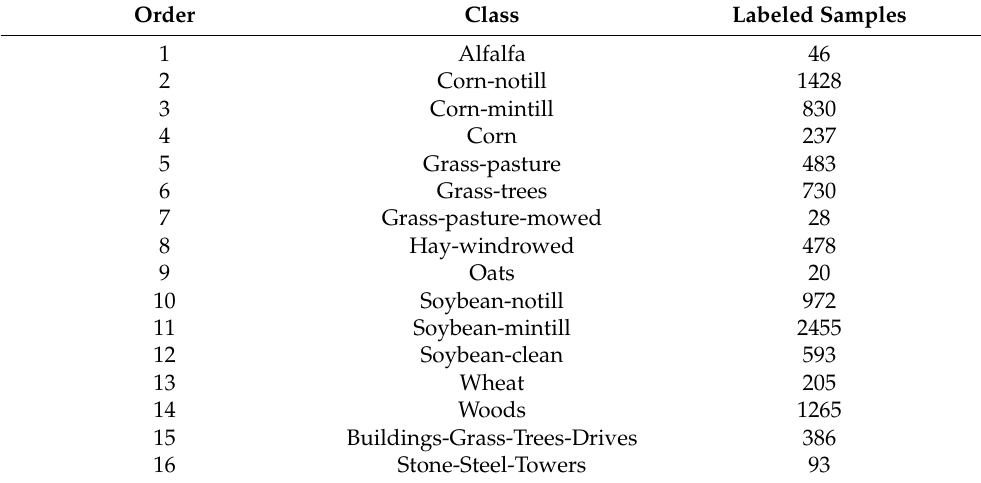
Table 2. Ground truth classes and samples of the Indian Pines dataset.